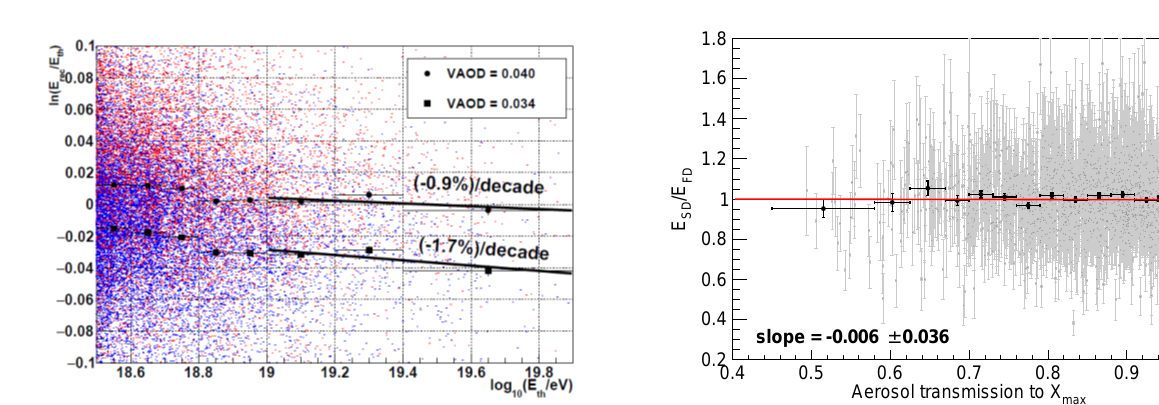
Figure 6. The ratio of the Auger surface and fluorescence detec- tor energies plotted versus the aerosol transmission to the shower maximum X max . A fit to a straight line (solid red line) is consis- tent with the slope of zero. A negative slope would correspond to underestimated aerosol e ff ects and a positive slope would in- dicate overestimated aerosol e ff